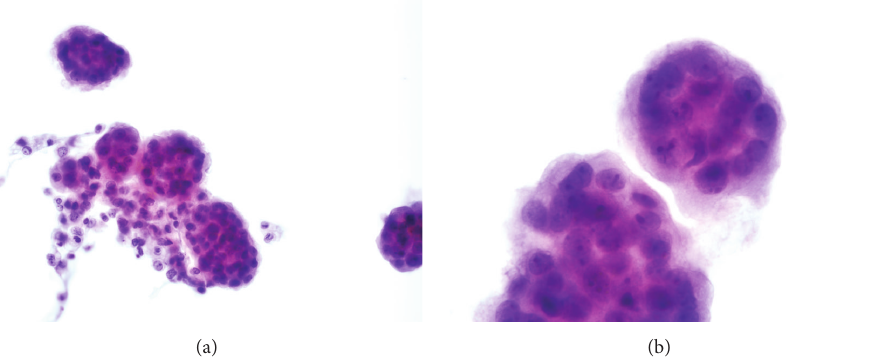
Figure 1: (a) Pleural fluid containing multiple spheres of neoplastic cells, Papanicolaou × 400. (b) Cell ball composed of tightly packed atypical oval cells with irregular hyperchromatic nuclei, Papanicolaou ×